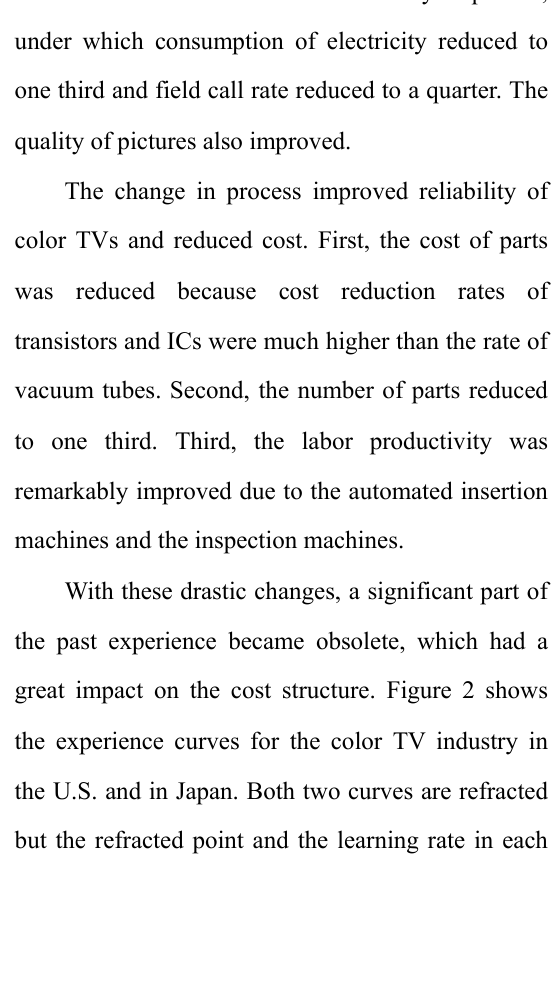
Figure 2. Experience Curve for Color